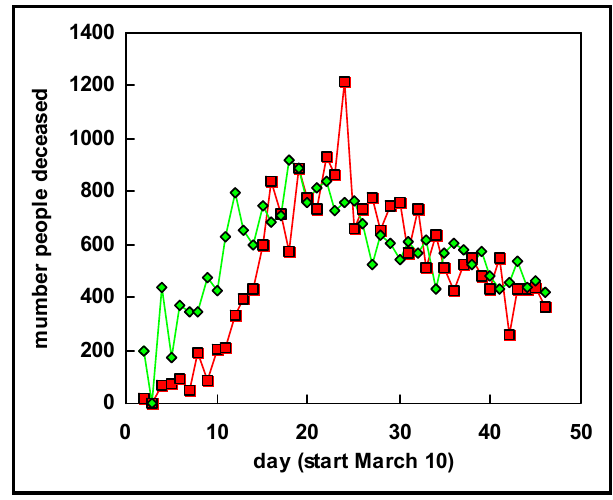
Figure 6. Daily increments during the period 10 March–24 April 2020 of deaths in Spain (red squares) and Italy (green diamonds).